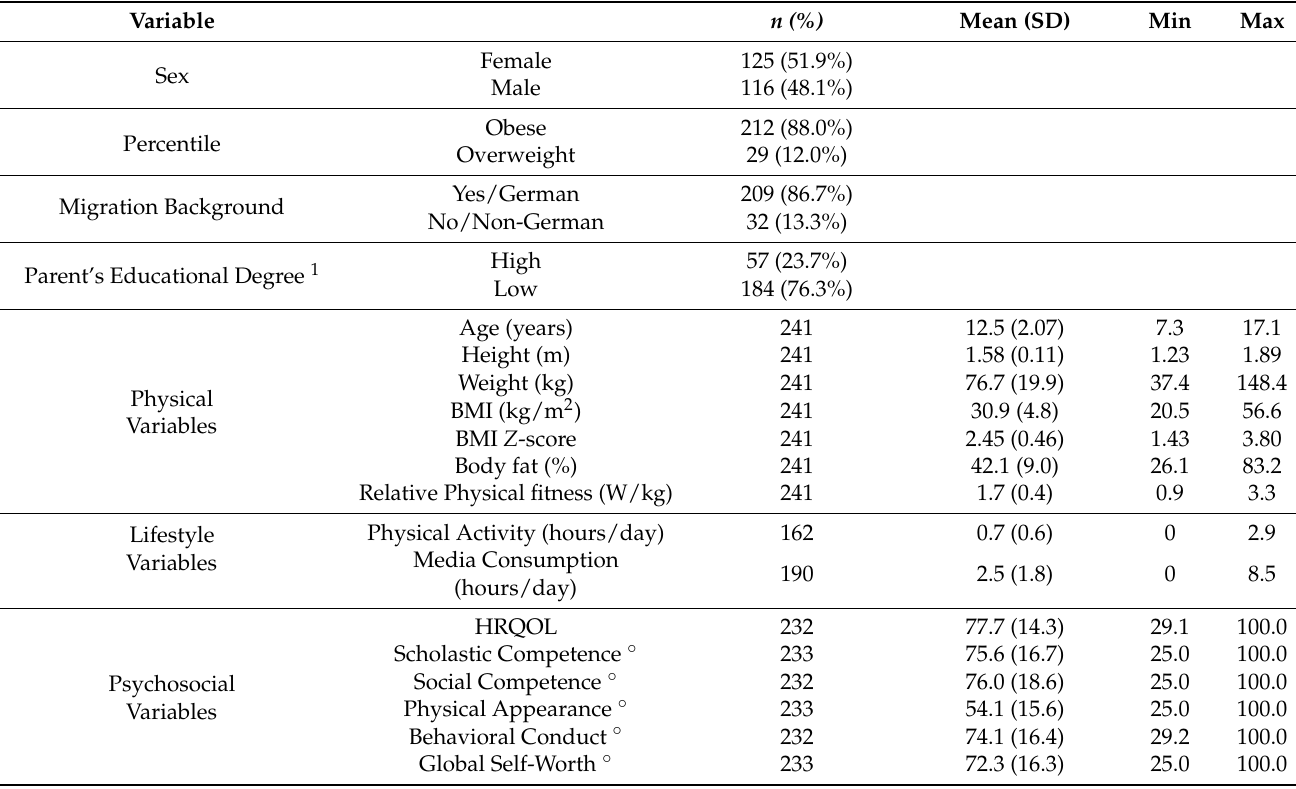
Table 1. Descriptive Sample Characteristics.